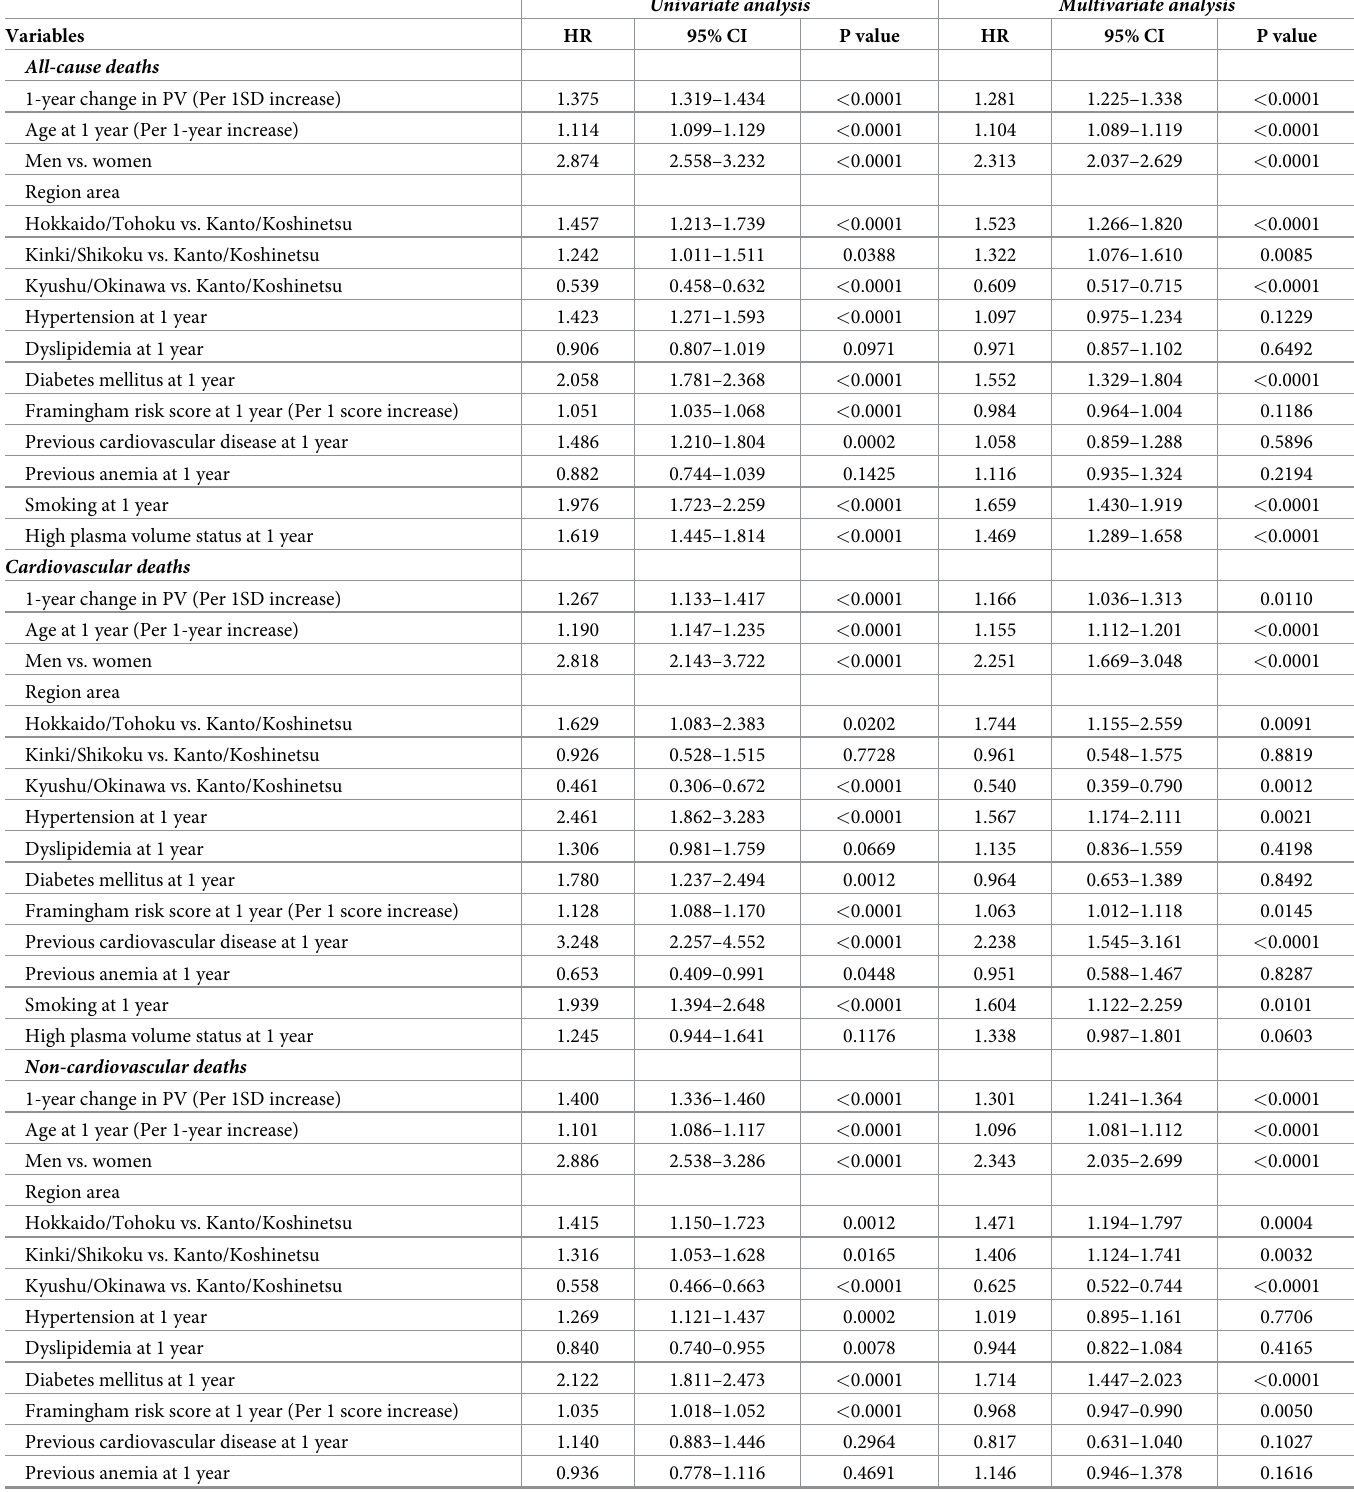
Table 5. Univariate and multivariate Cox proportional hazard analyses of predicting all-cause, cardiovascular, non-cardiovascular, and cancer